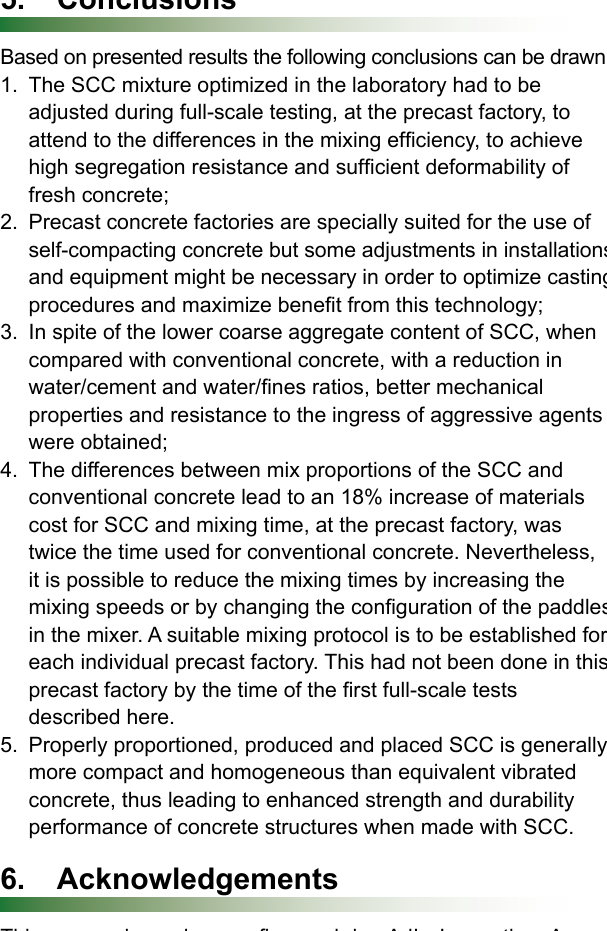
S. NUNES | H. FIGUEIRAS | J. SOUSA COUTINHO | J.